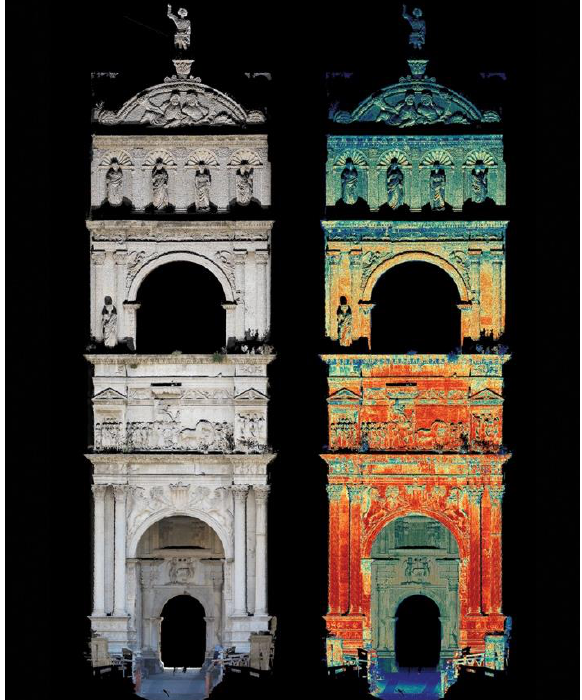
Figure 13. Orthoprojection of the tower tower stand points Figure 14. Orthoprojection of the Aragonese arc dot cloud with cloud, colored in false color depending on the variation of actual RGB data and false color depending on the luminance luminance.